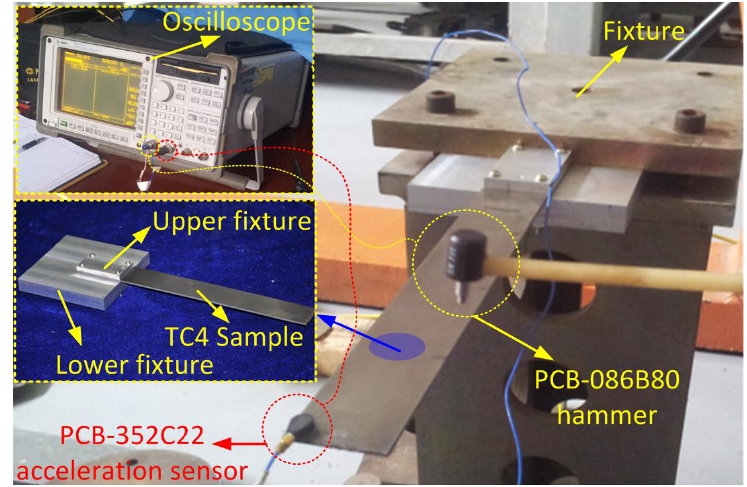
Figure 2. Equipment and specimens used in the impact modal tests.